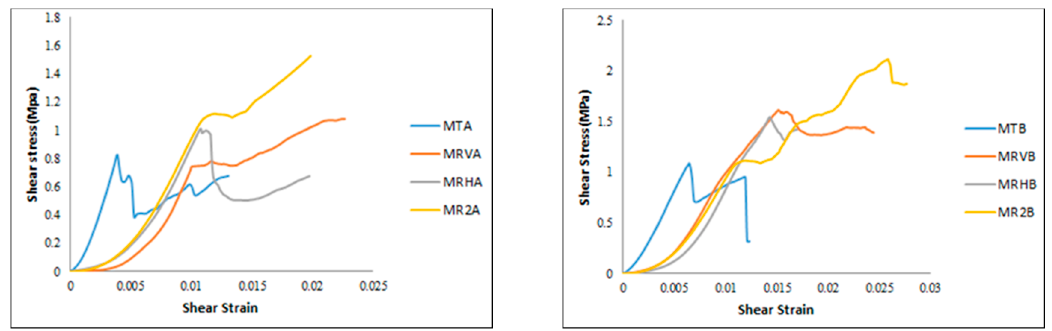
Figure 8. Shear stress–strain relationship for MRA and MRB reinforced masonry walls.